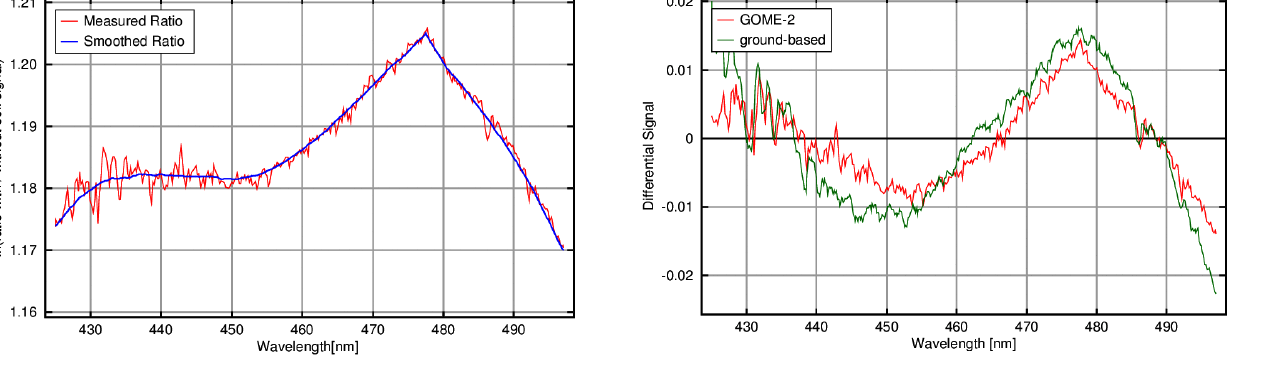
Fig. 6. Empirical soil signature derived from the logarithm of the ratio of two measurements from an orbit over the eastern Sahara. In the fit, the blue curve is used which has been smoothed to remove the residual signatures of the Ring effect clearly visible around 440nm. In order to maintain the sharp peak, smoothing has been performed over two separate regions left and right of 477.5nm. The two spectra used were taken on 1 August 2009 with centre co-ordinates at (15.89 ◦ N, 25.43 ◦ E) and (16.17 ◦ N, 23.99 ◦ E), re- spectively. The time difference between the two measurements was 0.375 s and the viewing line of sights at satellite were 2.76 ◦ and 13.44 ◦ .